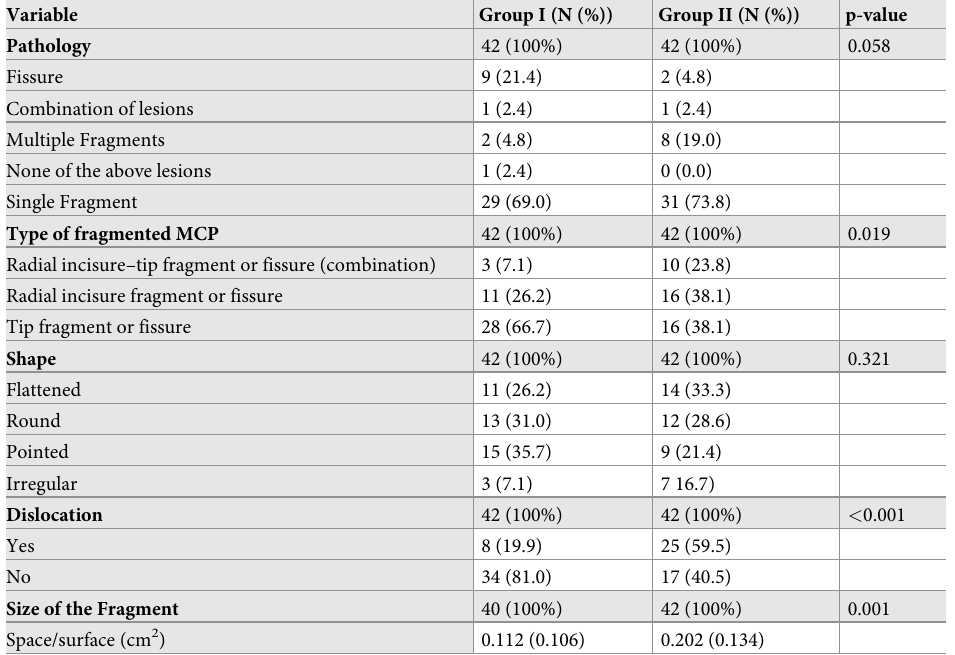
Table 5. General description of the lesions (CT